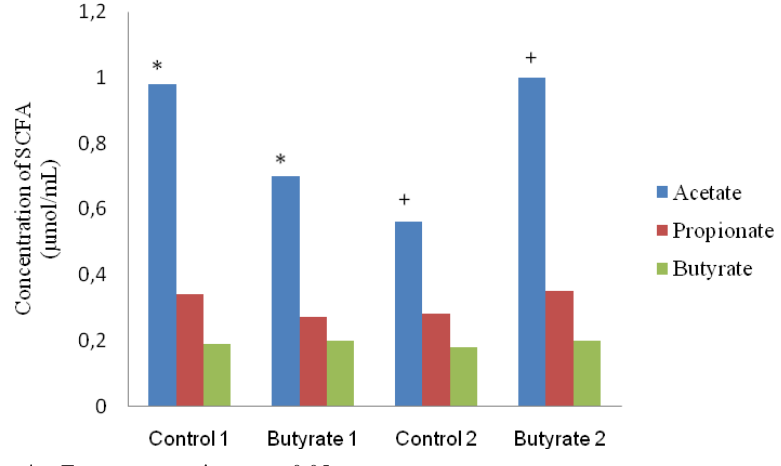
analyzed. A significant difference was observed (p<0.05) in the concentration value (µmol/mL) of acetate in comparison to the groups control 1 and butyrate 1, and in comparison to the groups control 2 and butyrate 2. The lipid profile of SCFA of the feces is demonstrated in the Figure